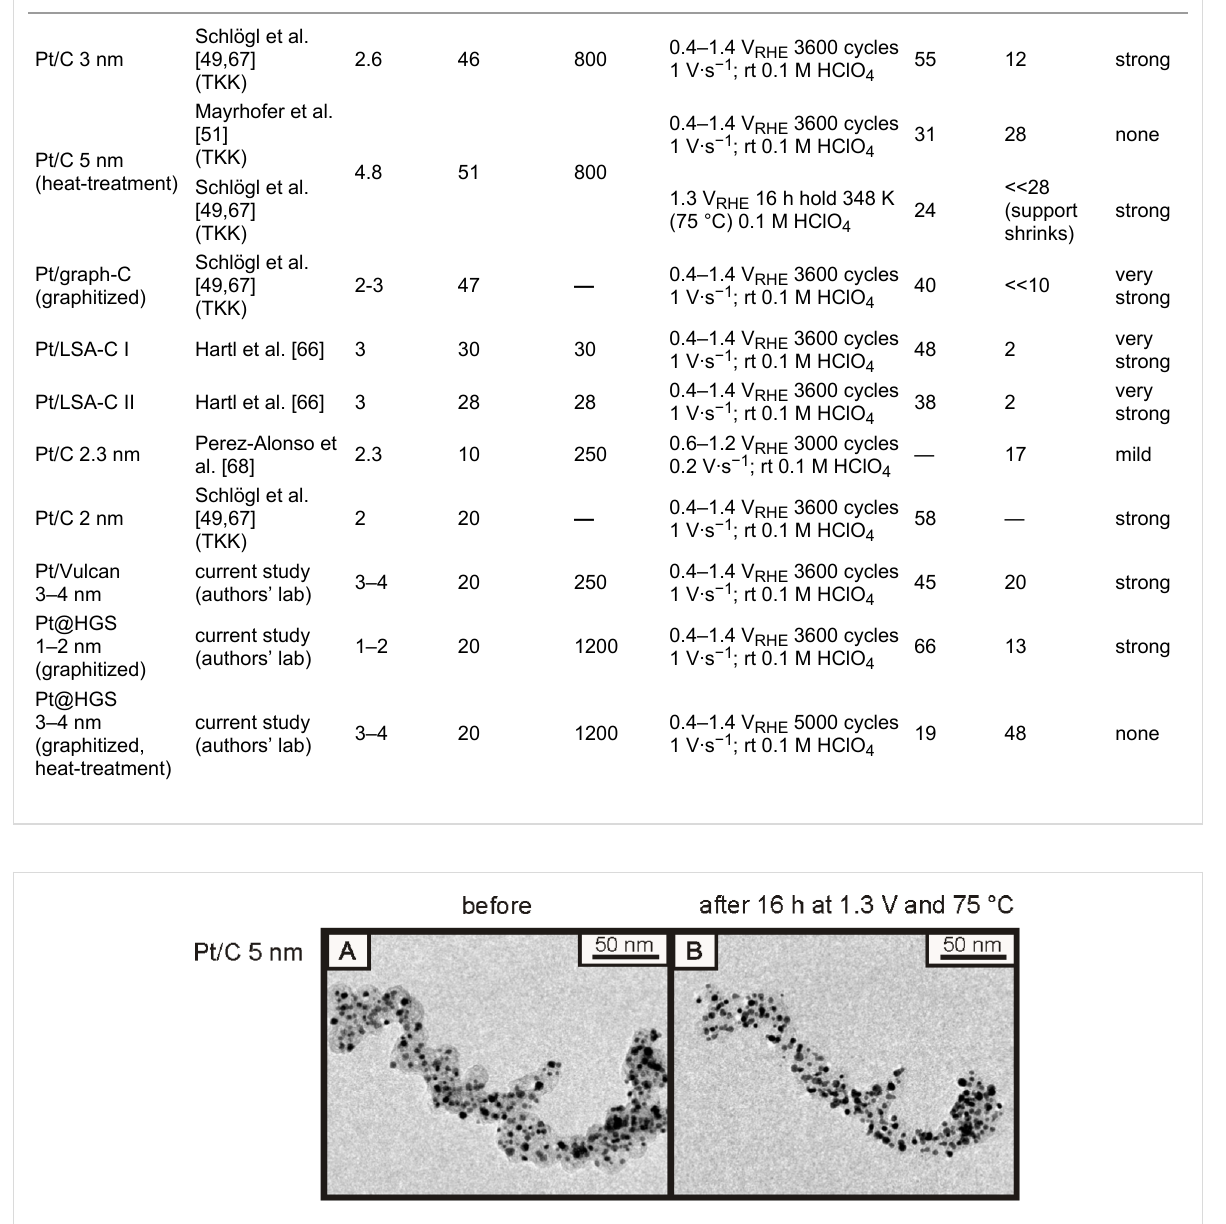
Figure 11. While a Pt/C catalyst (with BET of ca. 250 m 2 ·g − 1 as typical for standard Vulcan supports) with a particle size in